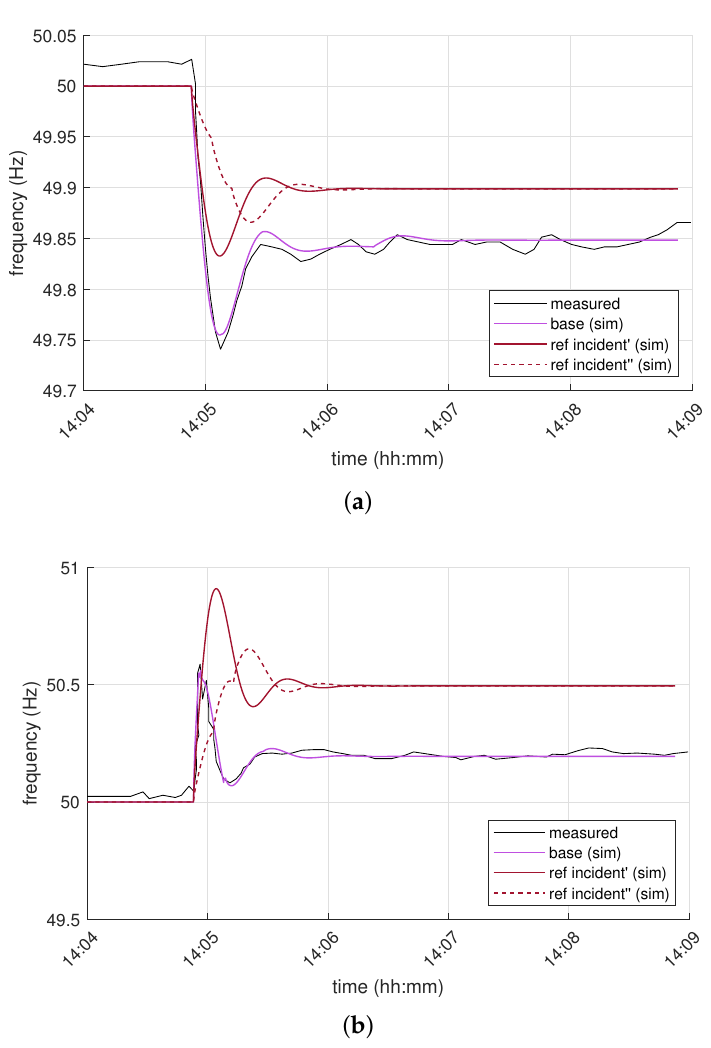
Figure 14. Comparison of simulation results for variant scenario of reference incident application concentrated (solid) and distributed (dashed): ( a ) frequency in North-West part; ( b ) frequency in South-East